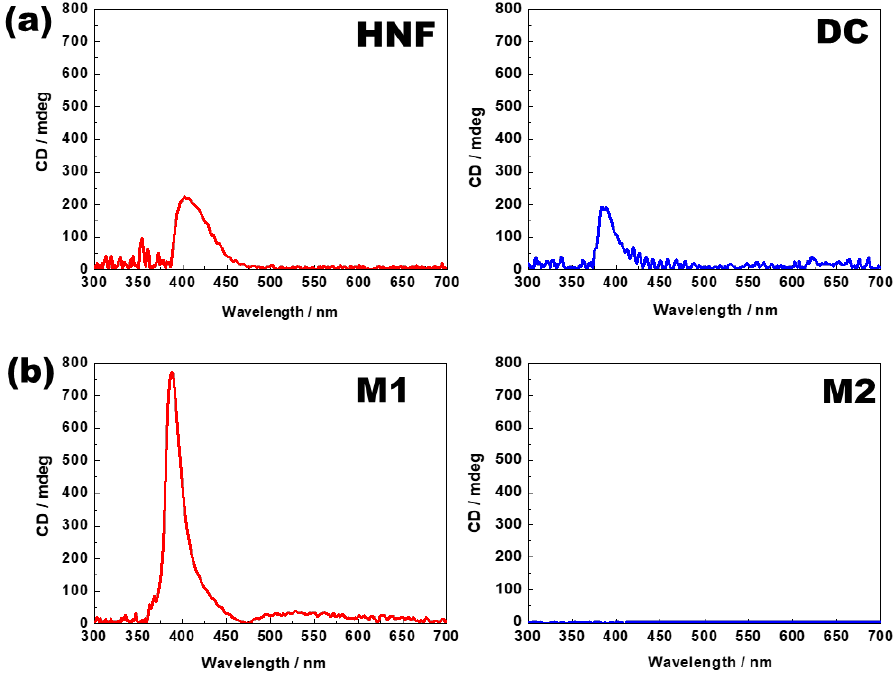
Figure 4. ( a ) Circular dichroism (CD) spectra of HNF in pure BC-A and DC in pure BC-B. ( b ) CD spectra of M1 and M2. All CD spectra were obtained at 30 °C.